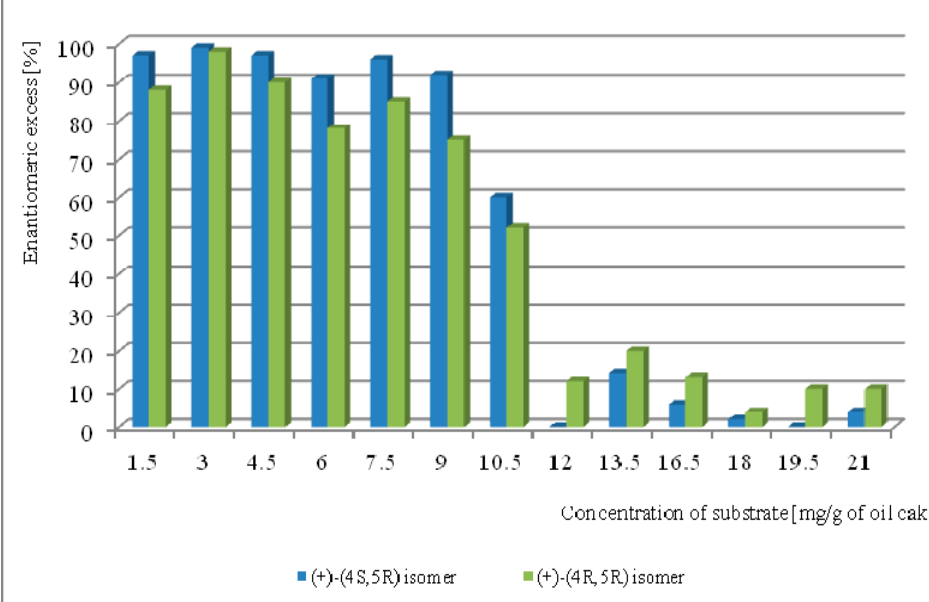
Figure 2. Effect of substrate concentration on biotransformation of diastereoisomeric mixture of whisky lactones catalyzed by F. oxysporum AM13 after five days (in % according to GC). The cultures were conducted using previously determined optimal conditions (33 ◦ C temperature, 60% moisture).